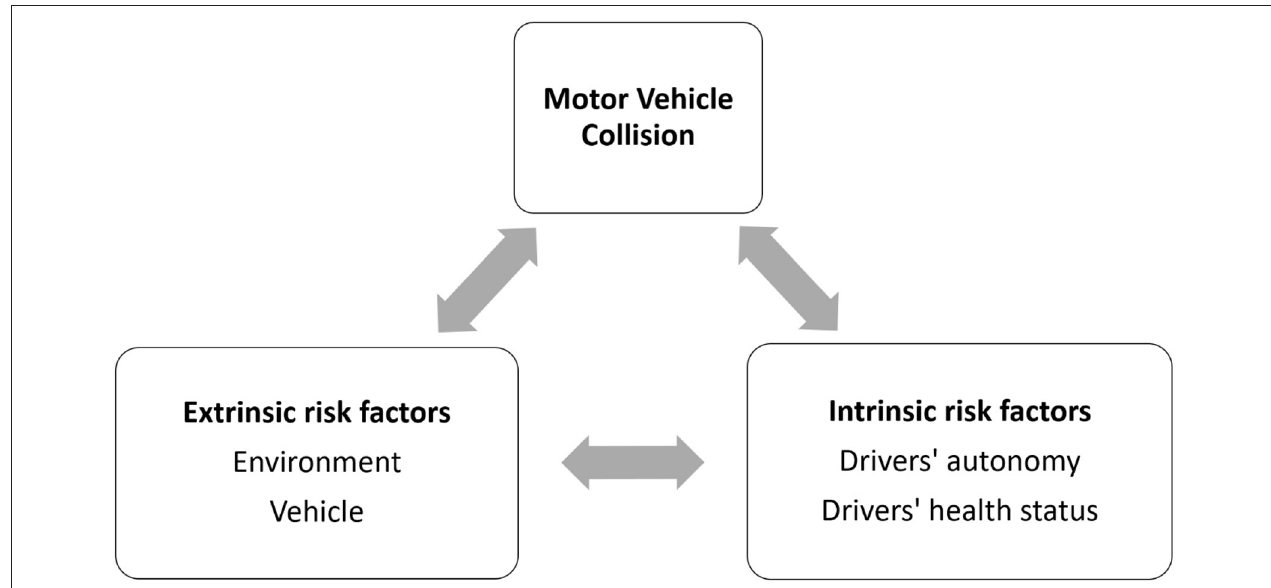
FIGURE 1 | Mapping of the association between MVC (motor vehicle collision), extrinsic (environment, vehicle), and intrinsic (drivers’ autonomy and health status: pre, during and post-MVC) risk factors found in the